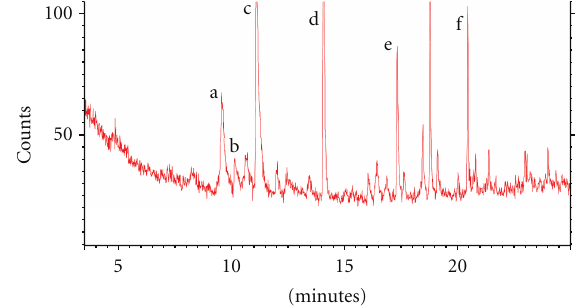
Figure 3: Headspace GC analysis of the volatile fraction obtained from compost C1. a: light terpene; b: butyrate; c: limonene; d: propanethiol; e: 2-decenale; f: 2-undecenale.